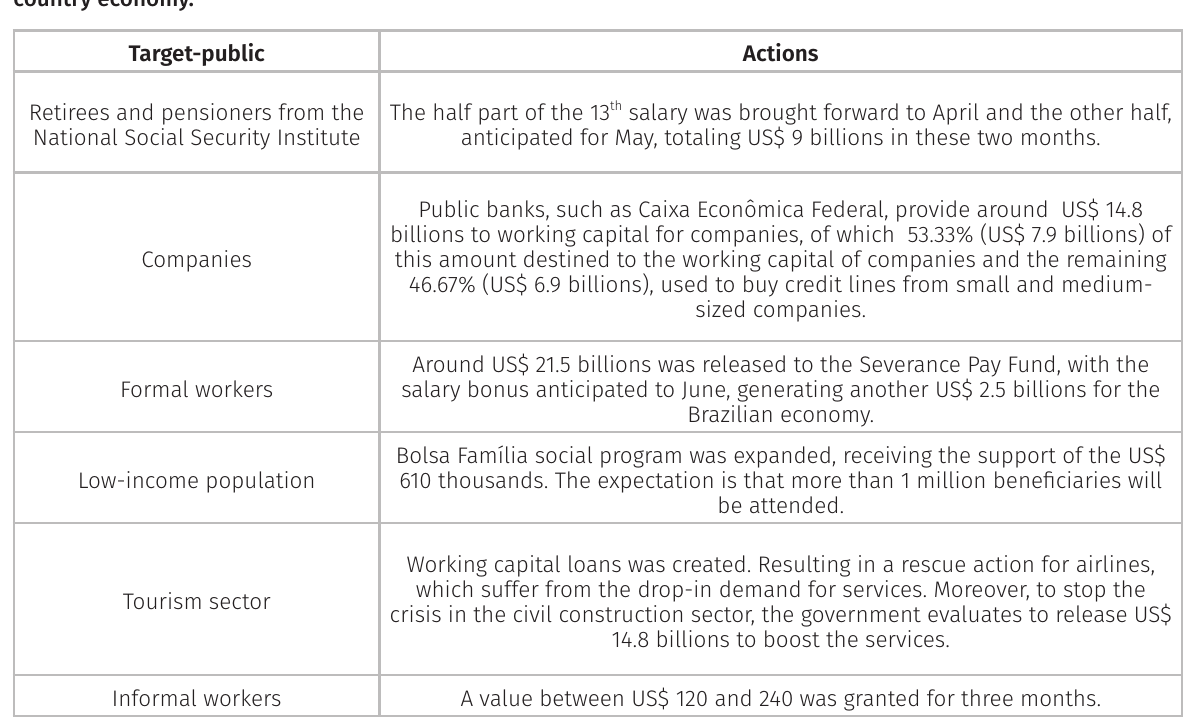
Table I. Brazilian government actions adopted to mitigate the increasing effects of the COVID-19 pandemic on the country